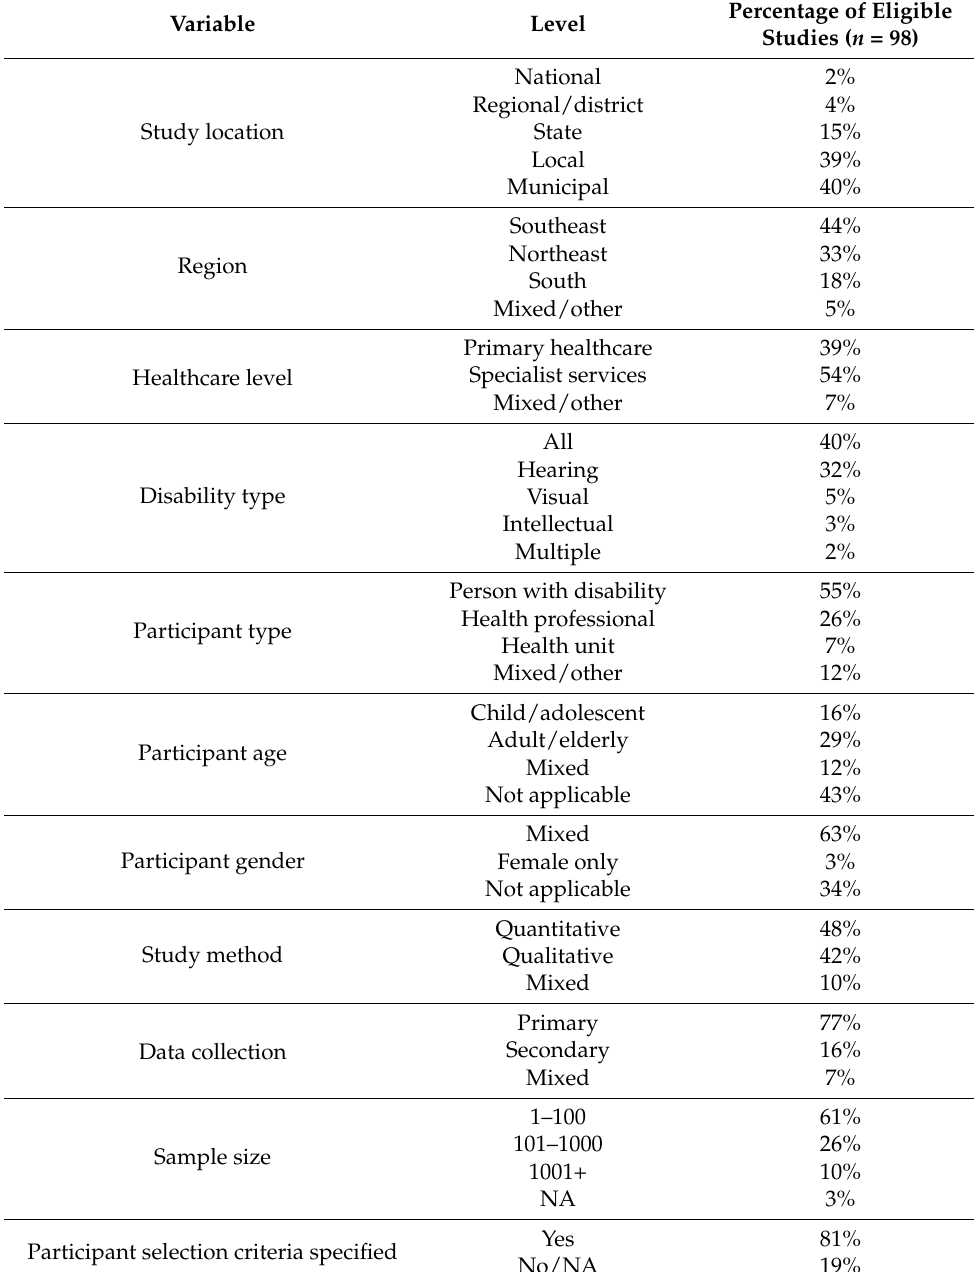
Table 1. Characteristics of studies included in the scoping